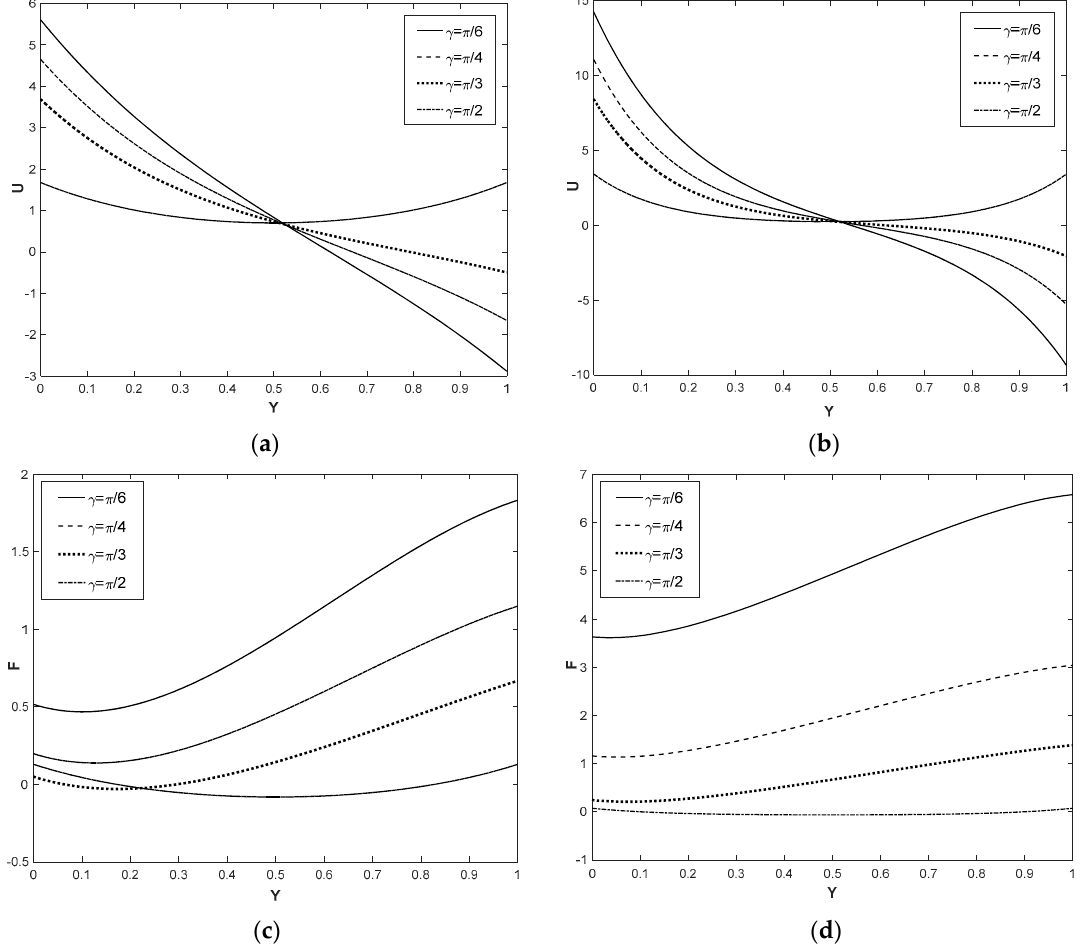
Figure 7. Velocity ( a , b ) and temperature ( c , d ) profiles, for Pe = 1, ϕ 1 = 0.1, ϕ 2 = 0.02 , for λ = 10 ( a , c ) and λ = 50 ( b , d ) for different values of the inclination angle of the channel.